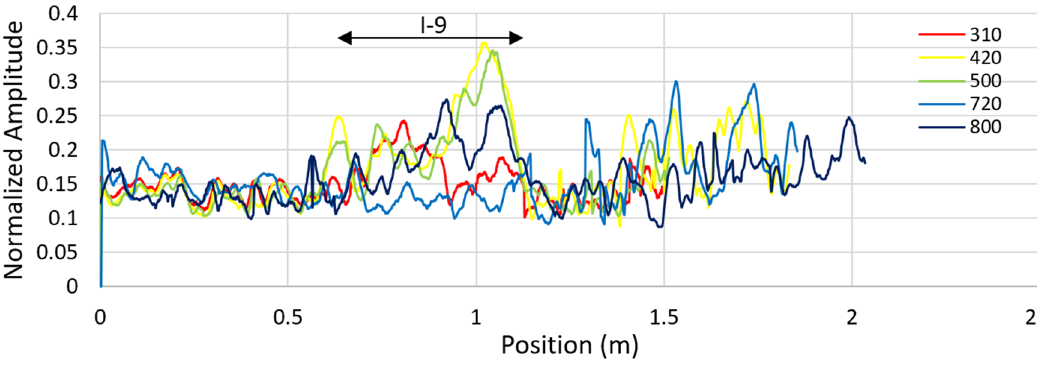
Figure 36. 2.6 GHz Normalized RW amplitudes on defect I-9, in the transversal direction vs. K loadings.